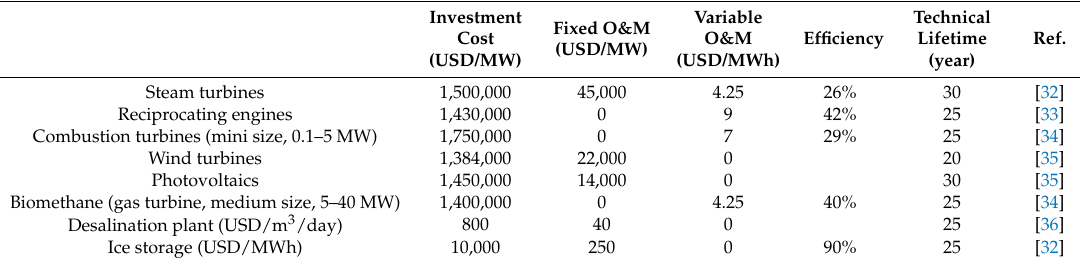
Table 4. Economic parameters used in the